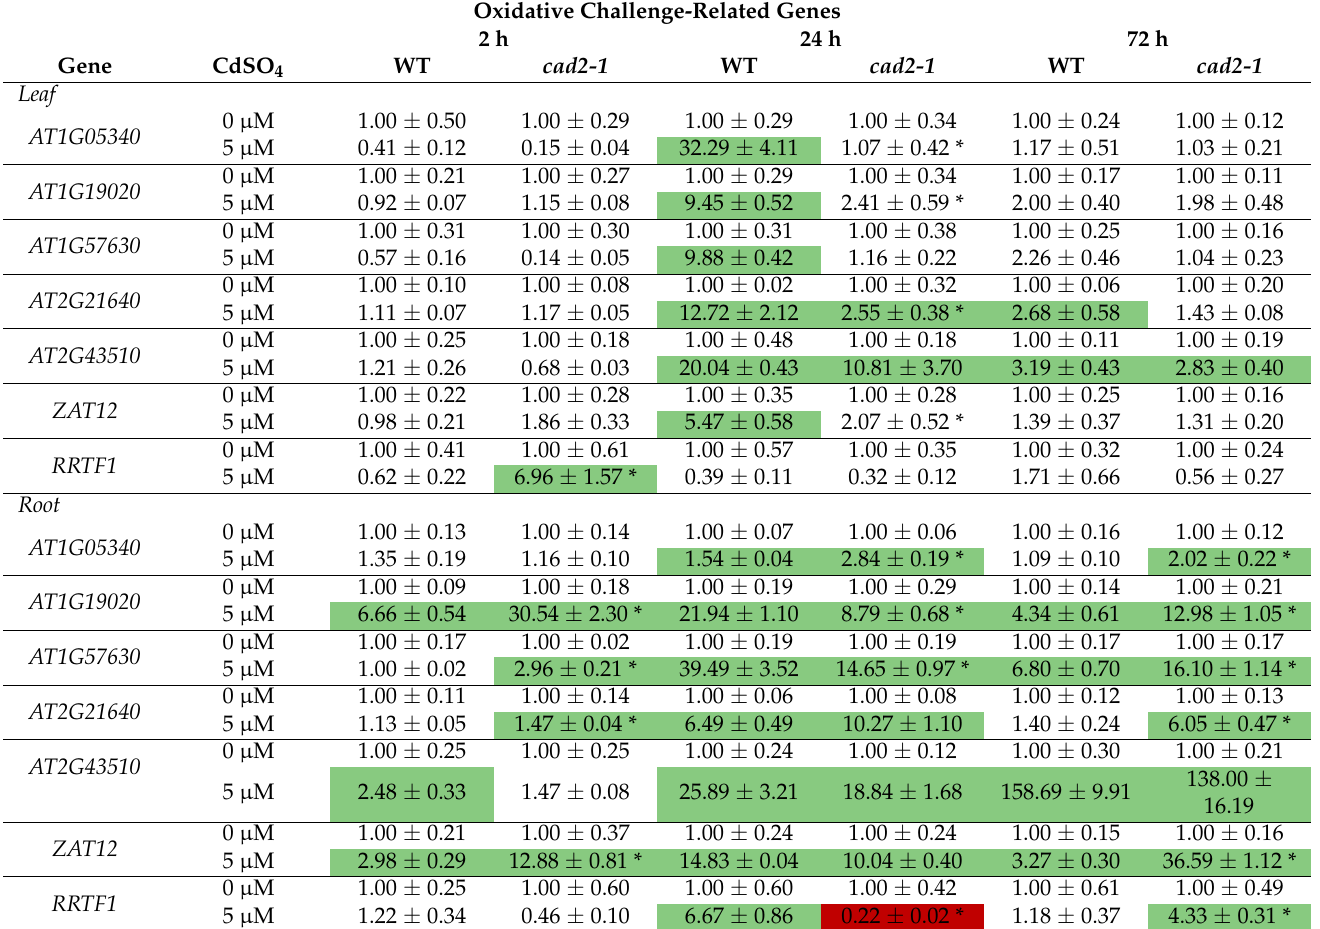
WT plants after 24 h of exposure to Cd. For mutant plants only, decreased gene expression levels were observed, and this for APX1 and APX2 after 2 h and 72 h, respectively (Table S5). Table 3. Relative gene expression levels of oxidative-challenge-related genes in leaves and roots of 3-week-old wild-type (WT) and cad2-1 mutant Arabidopsis thaliana plants grown under control conditions (0 µ M CdSO 4 ) or exposed to 5 µ M CdSO 4 during 2 h, 24 h, and 72 h. Data are presented as the mean ± S.E. of at least three biological independent replicates relative to the control of the corresponding genotype set at 1.00. Significant differences (2-way ANOVA: p < 0.05) between control and Cd-exposed plants of the same genotype, within each time point are marked in colour (upregulated: aa , downregulated: aa ). Significant differences between Cd-induced responses of both genotypes within each time point are indicated with an asterisk (*). ZAT12 : zinc finger of Arabidopsis thaliana 12, RRTF1 : redox-responsive transcription factor